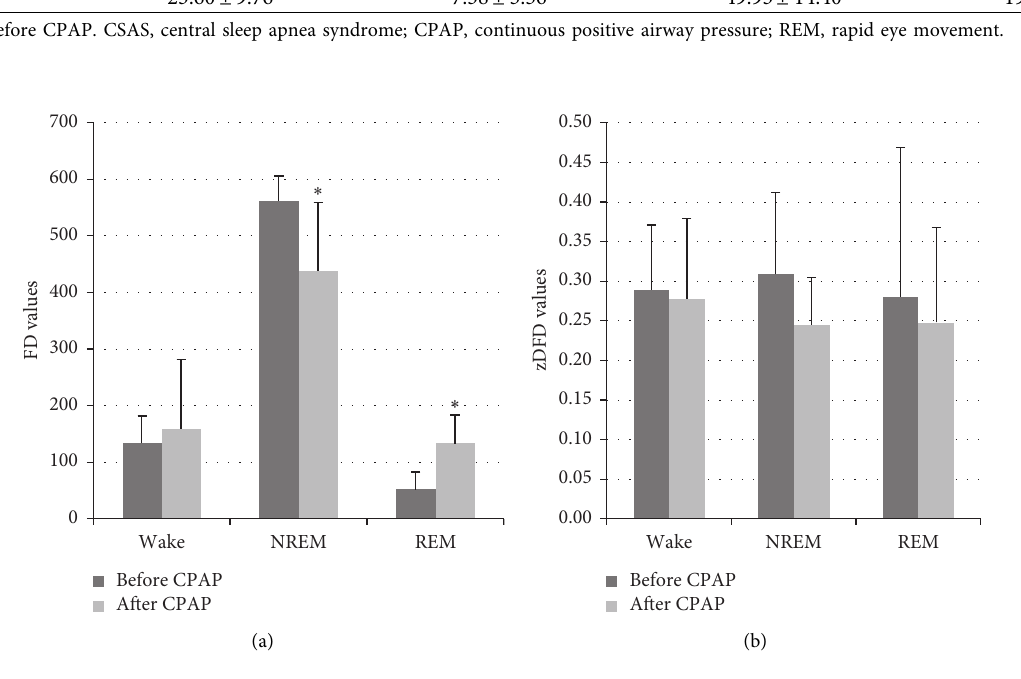
Figure 1: The changes of fractal dimension (FD) and zero-crossing rate of detrended FD (zDFD) in patients with primary central sleep apnea syndrome (CSAS) before and after continuous positive airway pressure (CPAP) treatment. (a) The FD significantly decreased in nonrapid eye movement (NREM) sleep but increased in rapid eye movement (REM) sleep with CPAP treatment ( ∗ p < 0 . 05; before CPAP). (b) There were no significant changes in zDFD before and after CPAP treatment in either NREM or REM sleep.